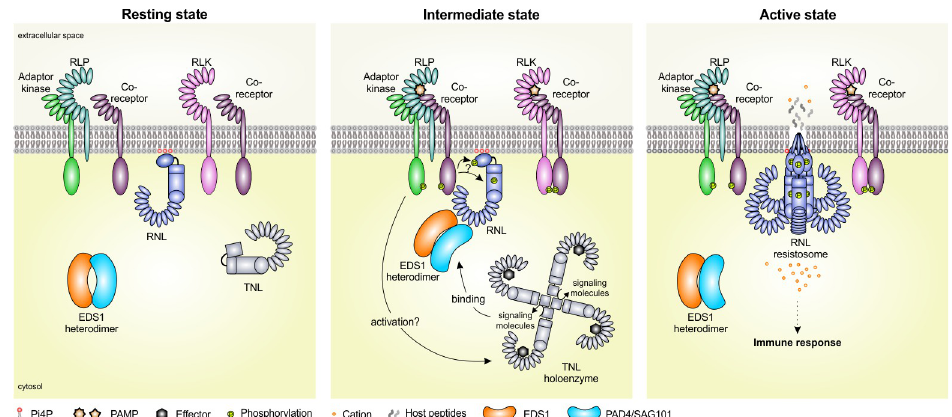
Fig 1. Schematic model of RNL activation and function during Arabidopsis innate immunity. AU : AbbreviationlisthasbeencompiledforthoseusedinFig 1 : Pleaseverifythatallentriesarecorrect : Resting state: In the absence of pathogens, RNLs exist likely as inactive monomers and in close proximity to cell surface-localized PRRs (including RLPs and RLKs). RNLs localize at the PM via direct interaction of their CC R domains with the anionic phospholipid Pi4P. Intermediate state: The perception of PAMPs by PRRs leads to the recruitment of a co-receptor and activates immune signaling by auto- and transphosphorylation. Components of the activated PRR core-complex may phosphorylate RNLs and “prime” them prior to full activation. Components of the activated PRR core-complex may also associate and activate downstream TNLs. TNLs, however, are also activated by recognition of pathogen- derived effector proteins. Activated TNLs assemble into a tetrameric complex. TIR domains have enzymatic activity and produce small signaling molecules that can bind directly to EDS1 heterodimers. Binding of these signaling molelcules to the EDS1-PAD4 heterodimer was shown to cause a conformational change in PAD4 that promotes the interaction with RNLs and may drive their full activation. Active state: Activation of RNLs may lead to the exposure of their N-terminal α 1-helix that could trigger the dissociation of the EDS1 heterodimer and the oligomerization of RNLs into a PM-associated resistosome. Activated RNLs promote cation influx (directly or indirectly) that leads to immune responses. It may also be possible that activated RNLs are involved in the release of host peptides/molecules that could activate immune signaling in neighboring cells. PAMP, pathogen-associated molecular pattern; PM, plasma membrane; PRR, pattern-recognition receptor; RLP, receptor-like protein; TIR, Toll-like/interleukin-1 receptor